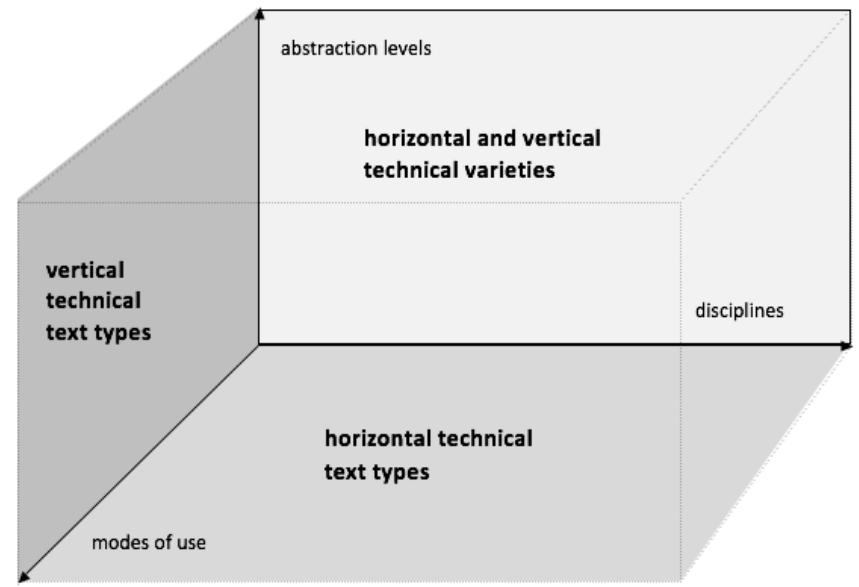
Fig. 1: Structures of LSP (translated from Roelcke 3